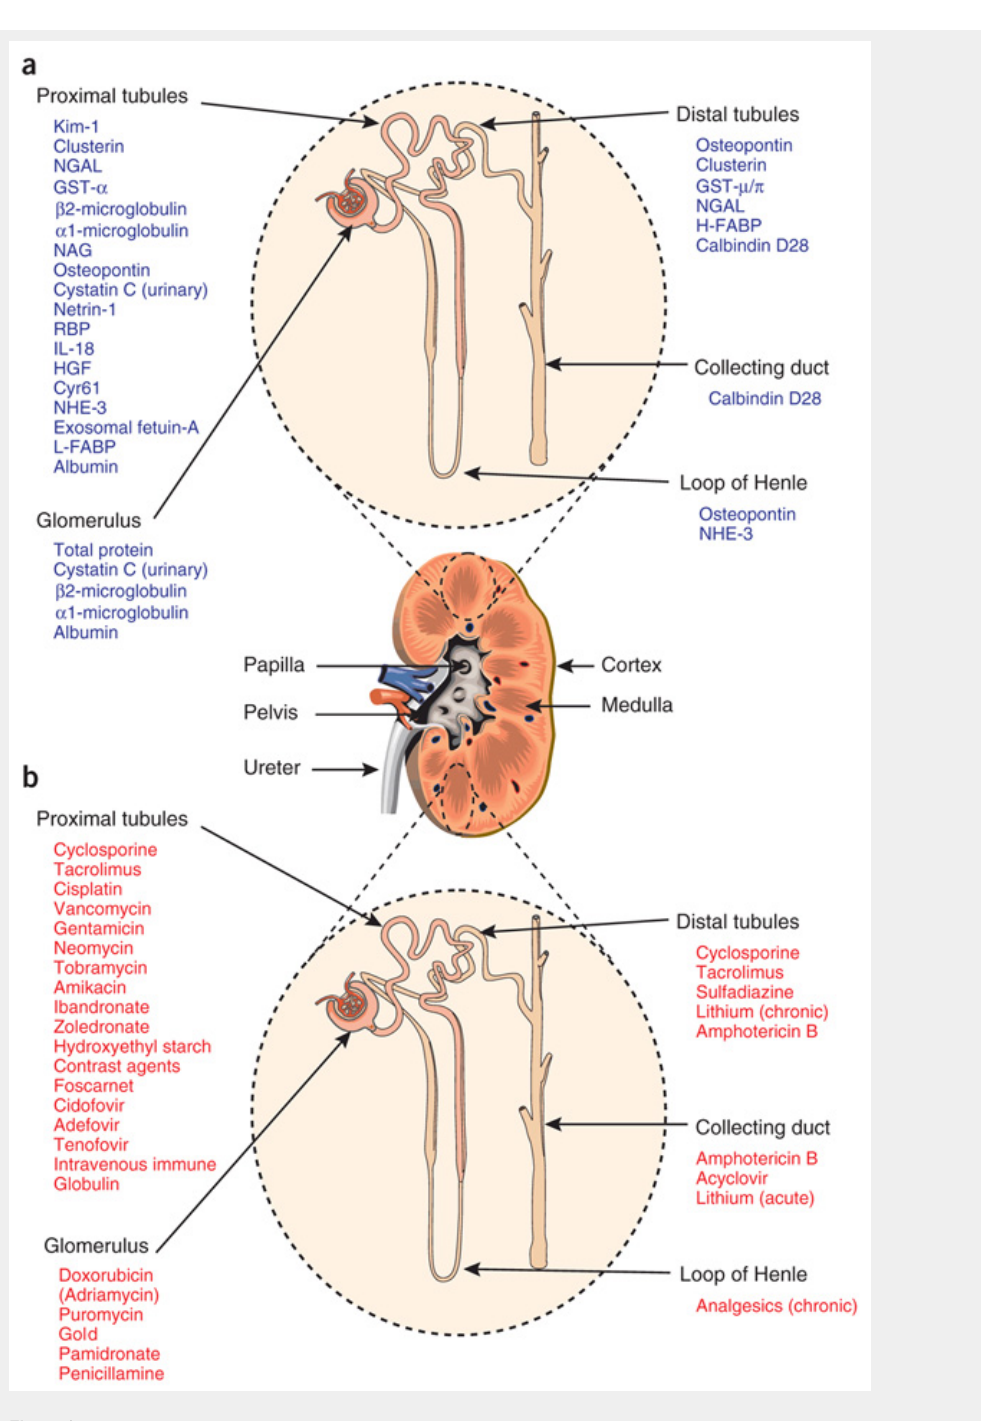
Figure 1 The utility of biomarkers to detect injury to specific nephron segments affected by various nephrotoxins. a Nephron segment-specific biomarkers of kidney injury. b Drugs that elicit site-specific toxicity in the kidney. (Source: Bonventre JV, Vaidya VS, Schmouder R, Feig P, Dieterle F. Next-generation biomarkers for detecting kidney toxicity. Nat Biotechnol. 2010;28:436–40. © Macmillan publishers Ltd, 2012. Reprinted with